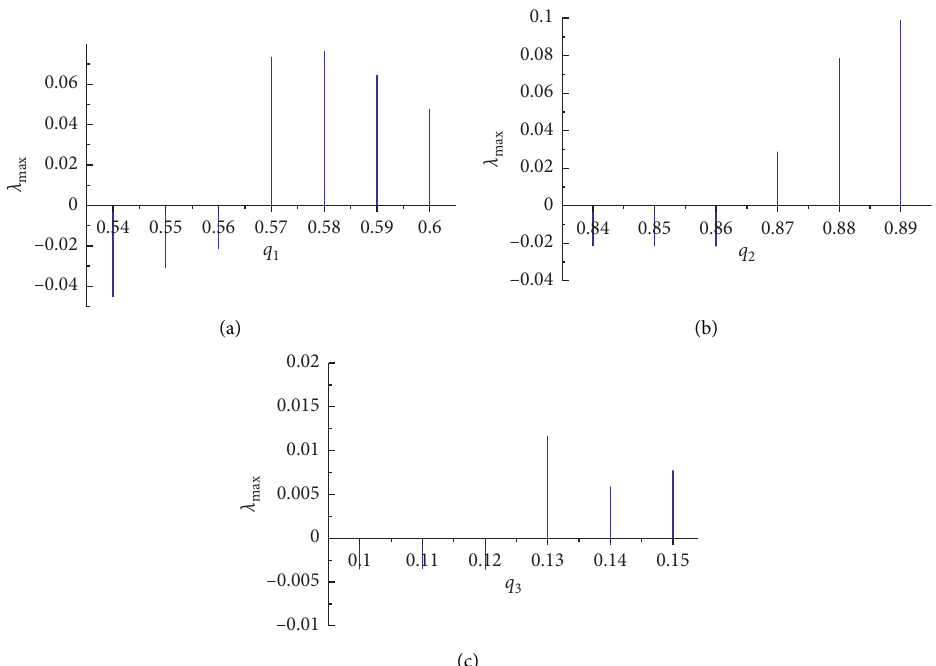
Figure 4: Largest Lyapunov exponents with variation of derivation orders. (a) q � q � 1. q 1 2